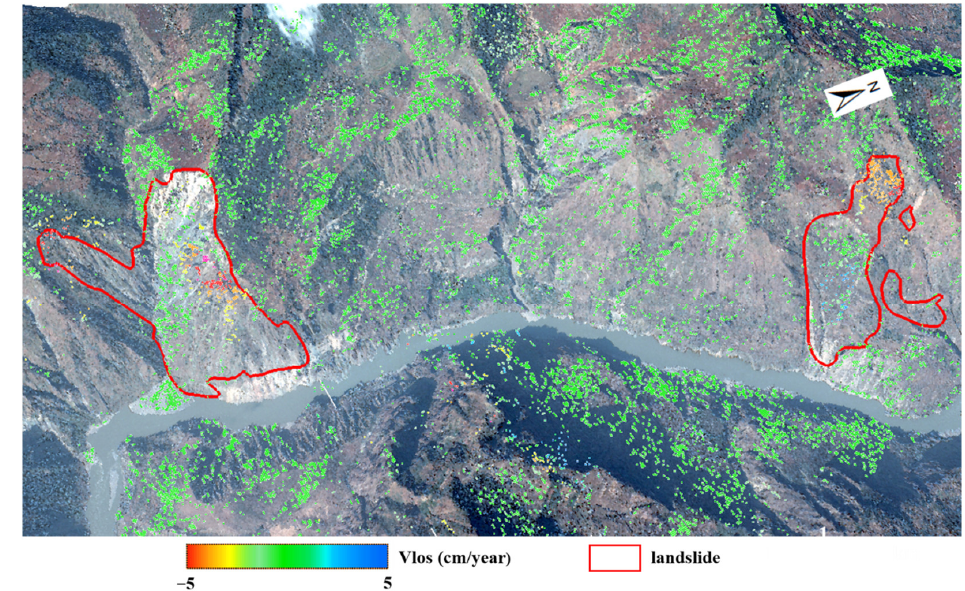
Figure 6. Landslide detection result (red polygons) using the OBIA method by integrating optical imagery with the InSAR−derived deformation rate map.